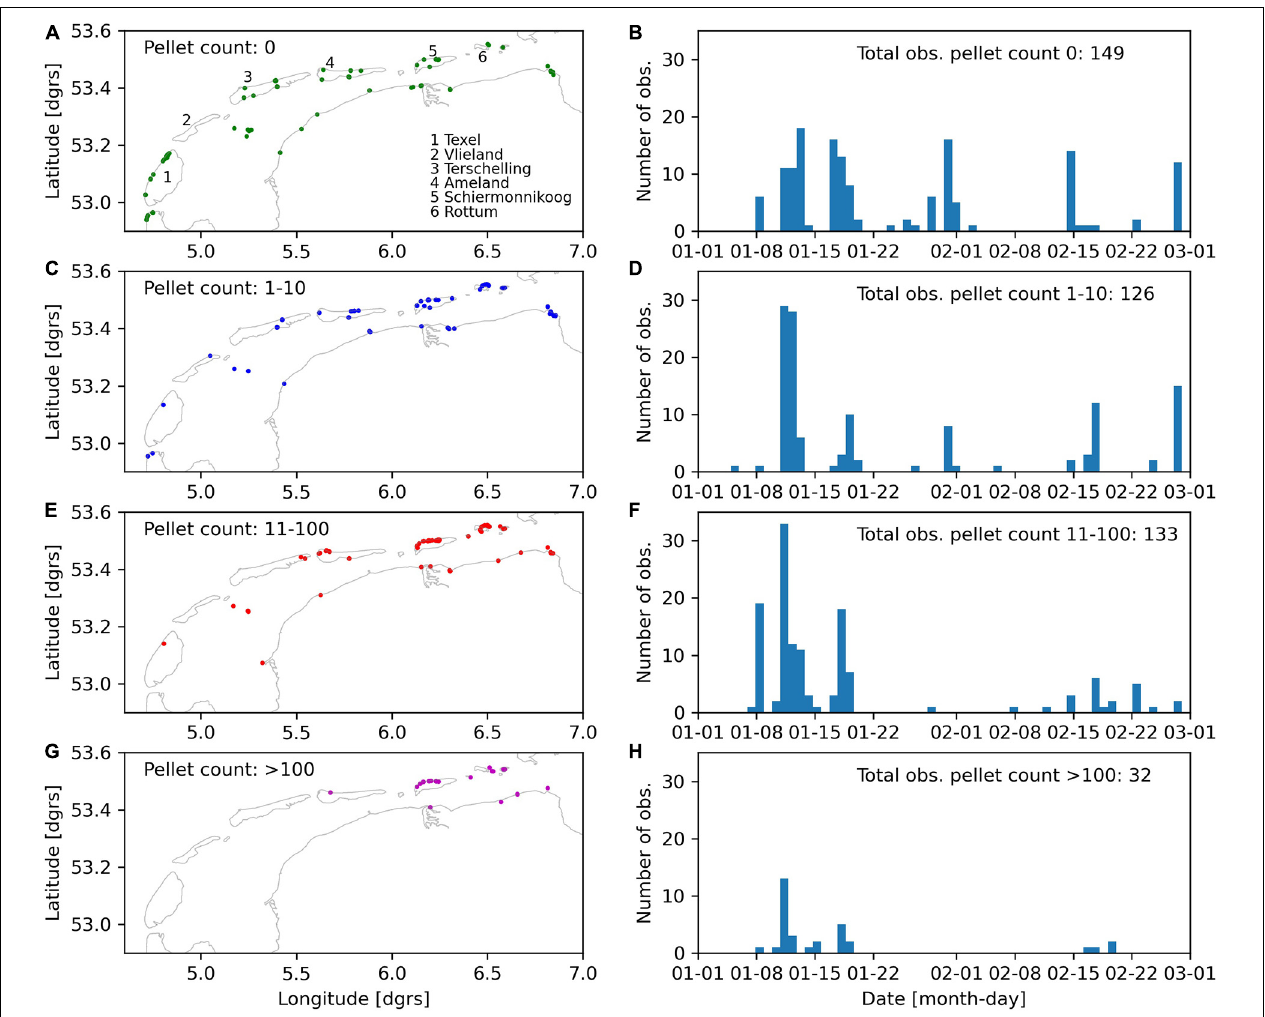
FIGURE 5 | Observations of HDPE pellets at the surface in a 0.4 × 0.4 m rectangle, entered on (See text footnote 5) in January and February 2019; maps of spatial distribution and histograms with number of observations per day. (A,B) No pellets, (C,D) 1–10 pellets, (E,F) 11–100 pellets, (G,H) more than 100 pellets. Locations are in decimal degrees latitude and longitude. Every mark is a separate observation, i.e., each location was visited